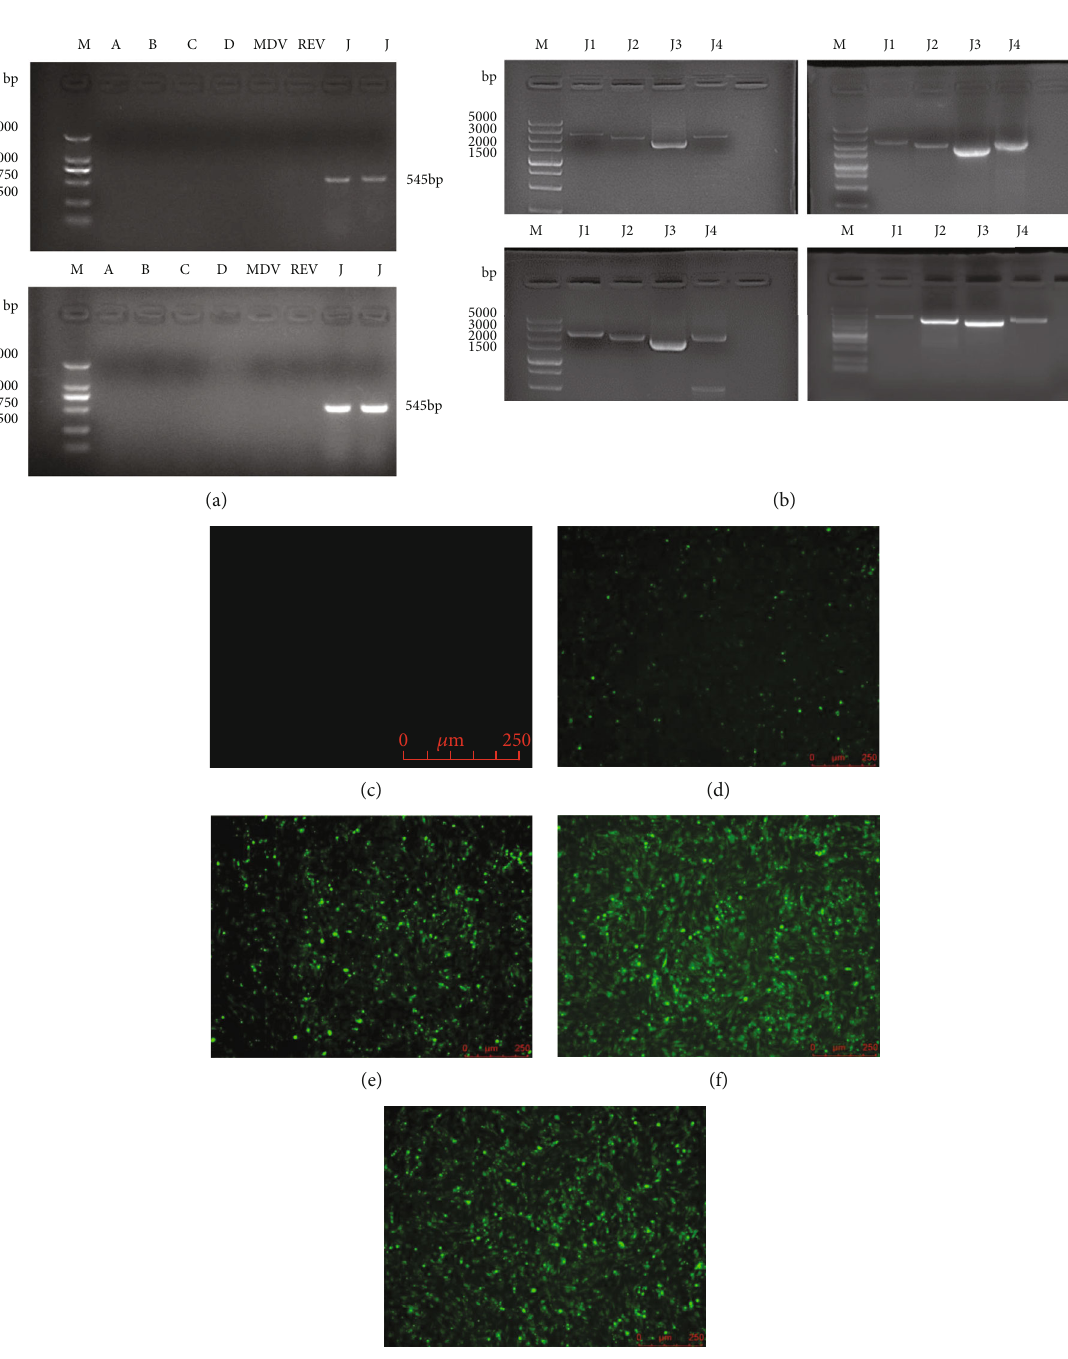
Figure 2: Identi fi cation of the four virus strains by PCR reaction and IFA response. In panel (a) are the PCR products that were electrophoresed on an agarose gel, and the four viruses at 545 bp, showing the speci fi c bands. (b) Agarose electrophoresis results of the full-length ALV-J genome ampli fi ed from the four strains of viruses. (c) Uninfected DF-1 cells as a negative control, at 100 × . (d – g) GD19GZ01 through GD19GZ04 strains inoculated into the DF-1 cells, respectively; the IFA response indicating speci fi c green fl uorescence, at 100 × . The numbers in the upper column of the gel chart are for the following: M is the marker, A to D are the ALV-A- to ALV-D-speci fi c primers, J is the ALV-J speci fi c primers for H5/H7, and J1 to J4 represent the four segments of the full length of the ALV- J genome. bp: base pairs. The numbers on the left indicate the lengths of the molecular weight